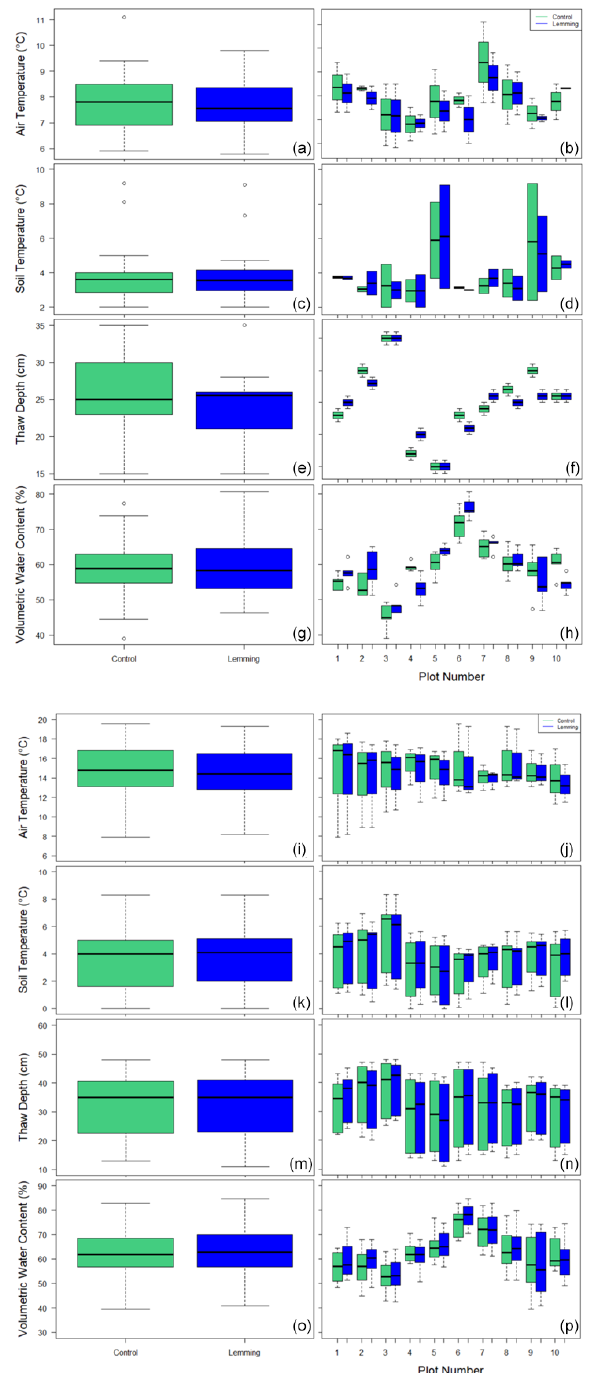
Figure A1. Box and whisker plots of environmental variables across treatment plots during (a–h) summer 2018 and (i–p) summer 2019. Environmental variables include (a, i) air temperature for the entire data set, (b, j) air temperature by plot, (c, k) soil temperature for the entire data set, (d, l) soil temperature by plot, (e, m) thaw depth for the entire data set, (f, n) thaw depth by plot, (g, o) soil moisture for the entire data set, and (h, p) soil moisture by